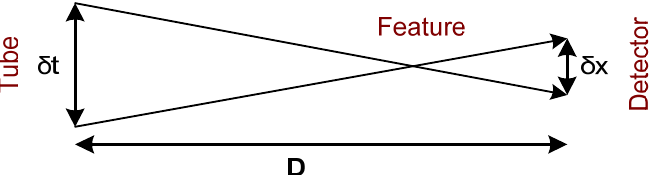
Figure 2. The idea of a rectilinear tomographic scanning system aiming to ensure the blur out of projection details.